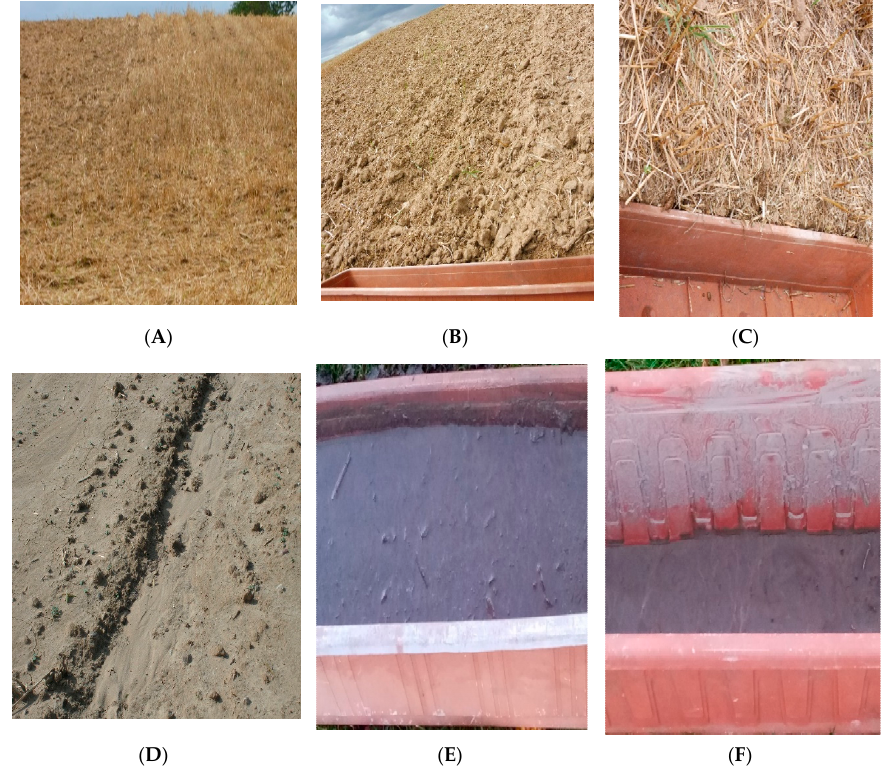
Figure 3. The site of the surface runoff and soil loss experiment. ( A ) Field on a slope of 11% gradient; ( B ) Sedimentation container on a ploughed slope; ( C ) Sedimentation container on a mulched slope (strip-till one-pass, ST-OP); ( D ) Field surface after storm (erosion), conventional cultivation (CT); ( E ) Soil lost from CT field; ( F ) Soil lost from ST-OP.